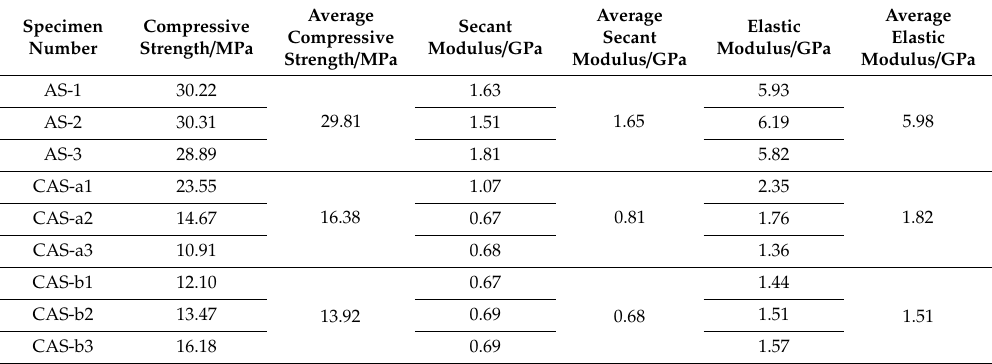
Table 3. Mechanical properties of single coal, single rock, and structural specimens.